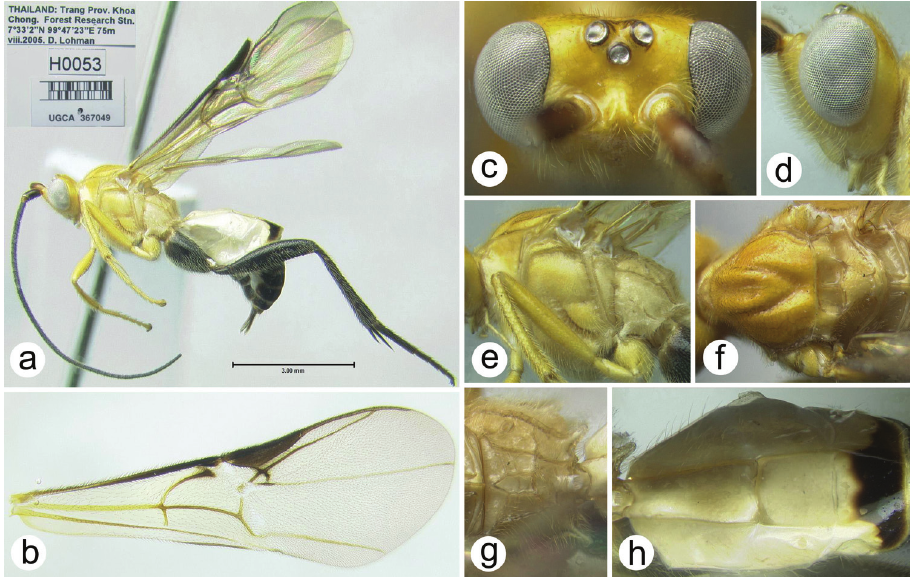
Figure 20. Zelodia wangi sp. n. a lateral habitus b wings c dorsal head d lateral head e lateral mesosoma f dorsal mesosoma g dorsal propodeum h dorsal